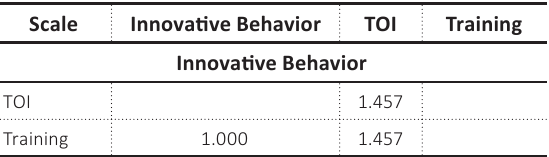
Table 4. Collinearity assessment